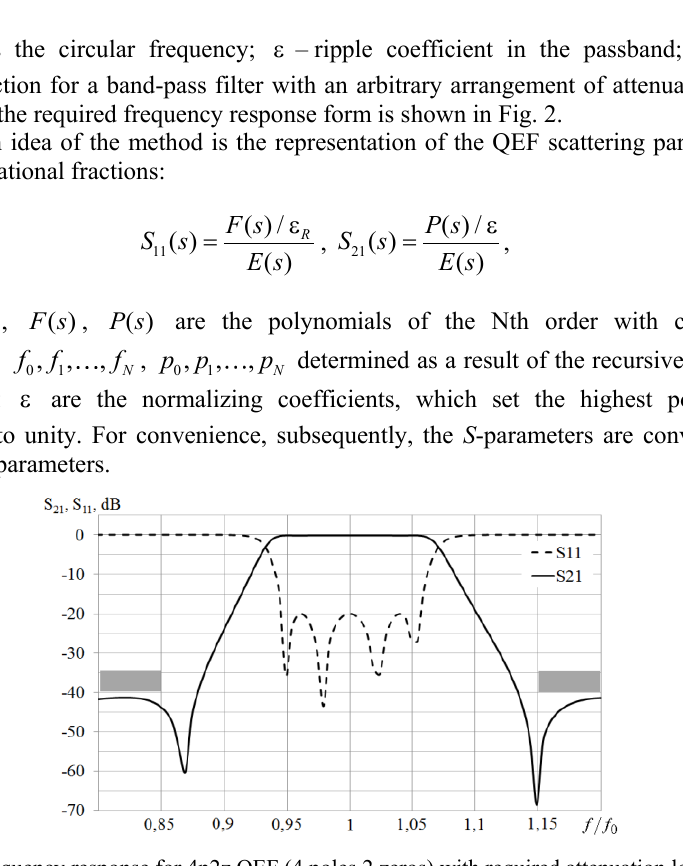
Fig. 2 . The frequency response for 4p2z QEF (4 poles 2 zeros) with required attenuation